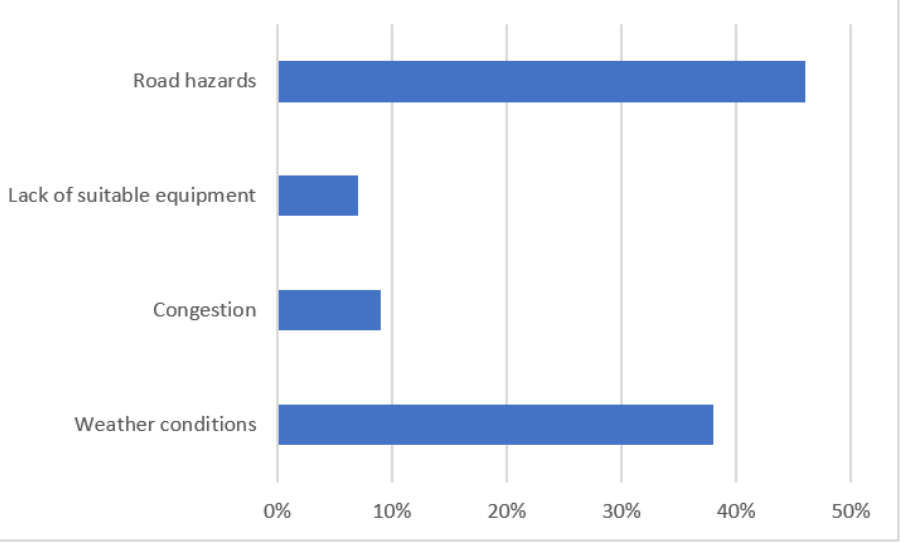
Figure 3. Travel difficulties reported by the couriers in 2018. Source: Survey by the authors.